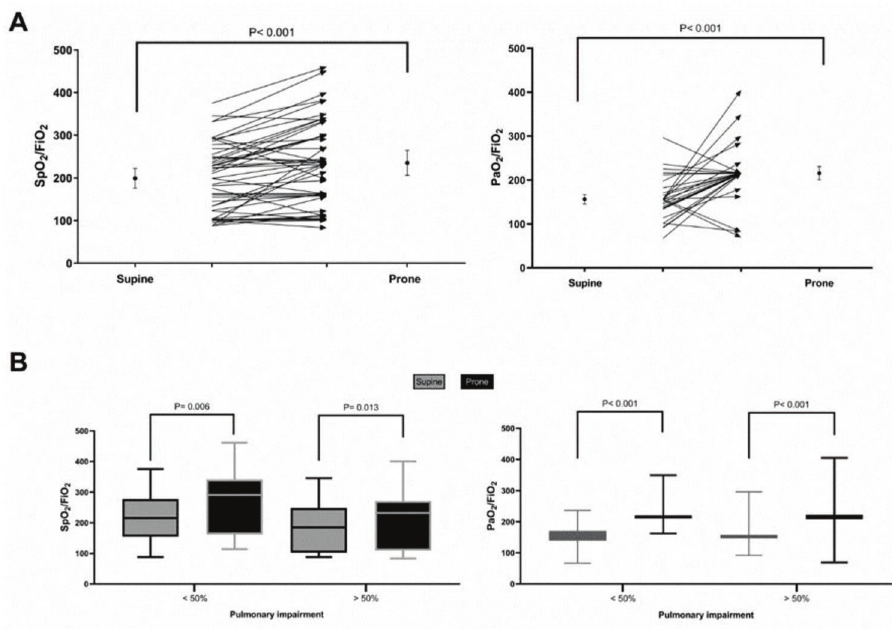
Figure 2 - Comparison of SpO 2 /FiO 2 and PaO 2 /FiO 2 in the supine and prone positions (A); comparison of SpO 2 /FiO 2 and PaO 2 /FiO 2 in the supine and prone positions based on pulmonary involvement (B).